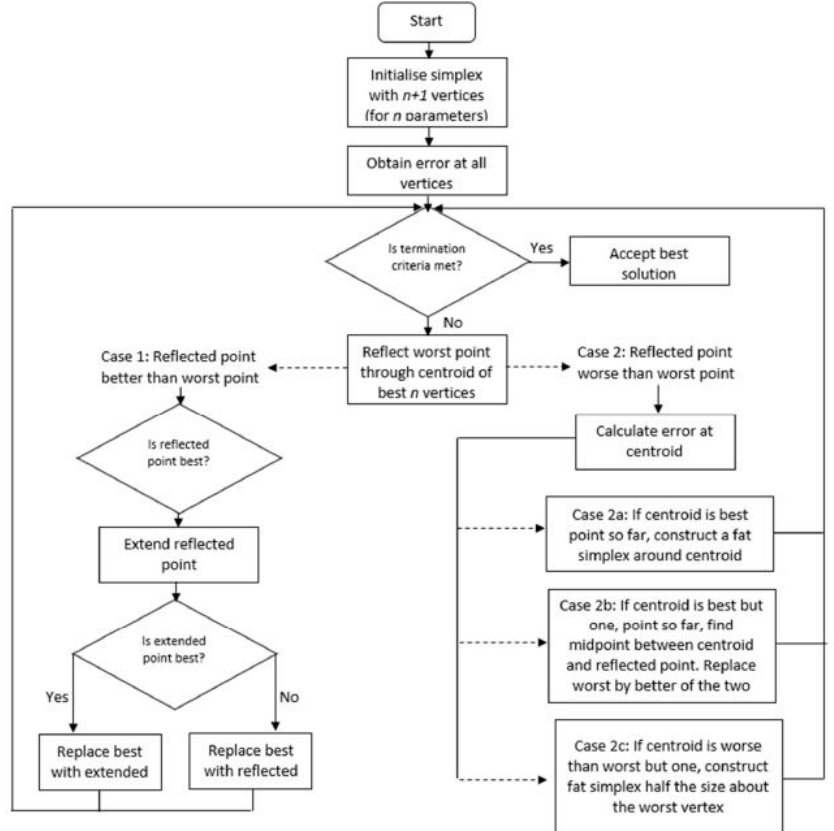
Figure 3. Flowchart for the Nelder–Mead optimization algorithm [18].